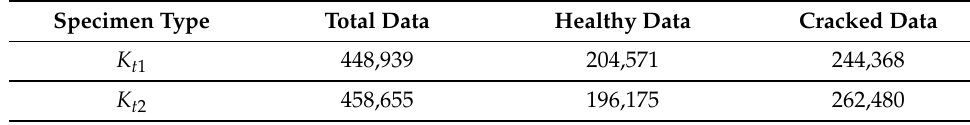
Table 1. Data distribution among the two classes for both K t